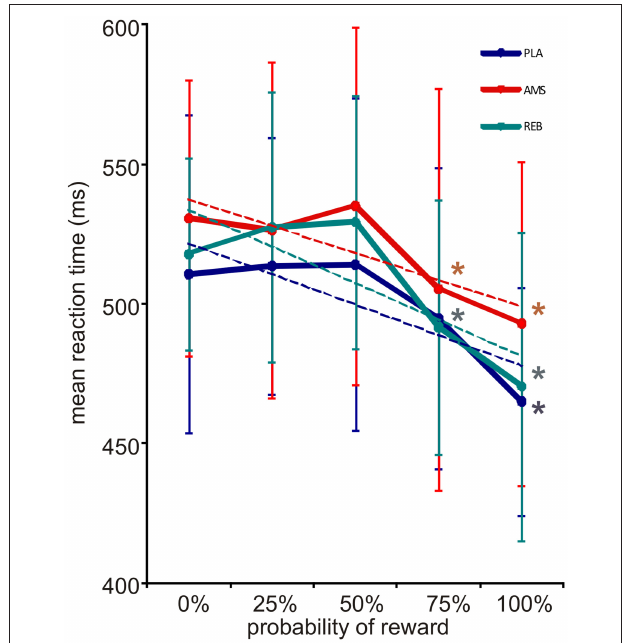
FIGURE 2 | Reward expectation and corresponding reaction times (with standard deviations). Mean reaction times of the fMRI reward paradigm accelerated under all treatment conditions according to increased reward probability (blue = placebo, PLA; red = amisulpride, AMS; green = reboxetine, REB). Dotted lines depict linear trendlines for each treatment condition. An ANOVA revealed significant results for the factor level of probability (see Results section). In post-hoc testing, a significant acceleration of reaction times was observed when comparing 0 to 100% under PLA and 0 to 75% reward probability under AMS and REB. *Indicate statistical significance ( p < 0.05) in post-hoc t